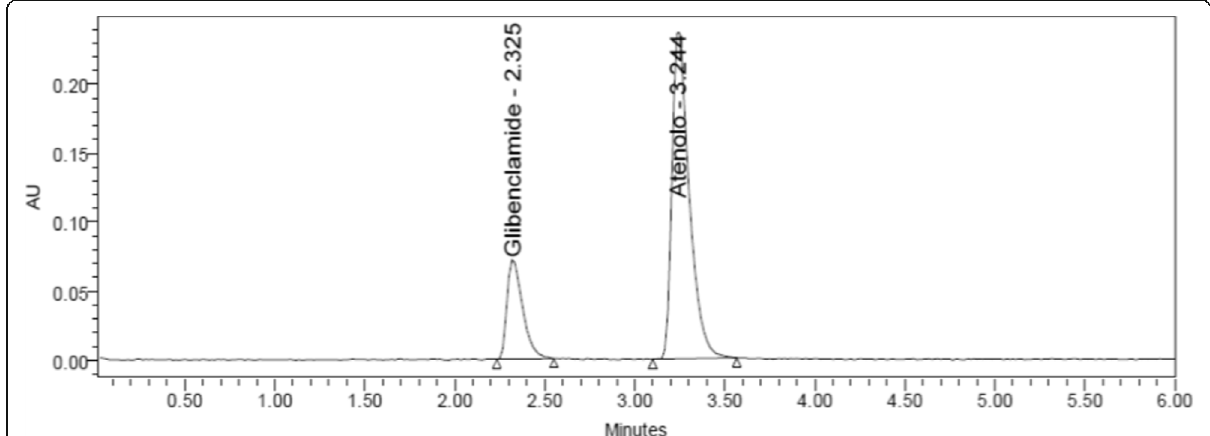
Fig. 7 HPLC chromatograms of mobile phase containing GLB and ATN